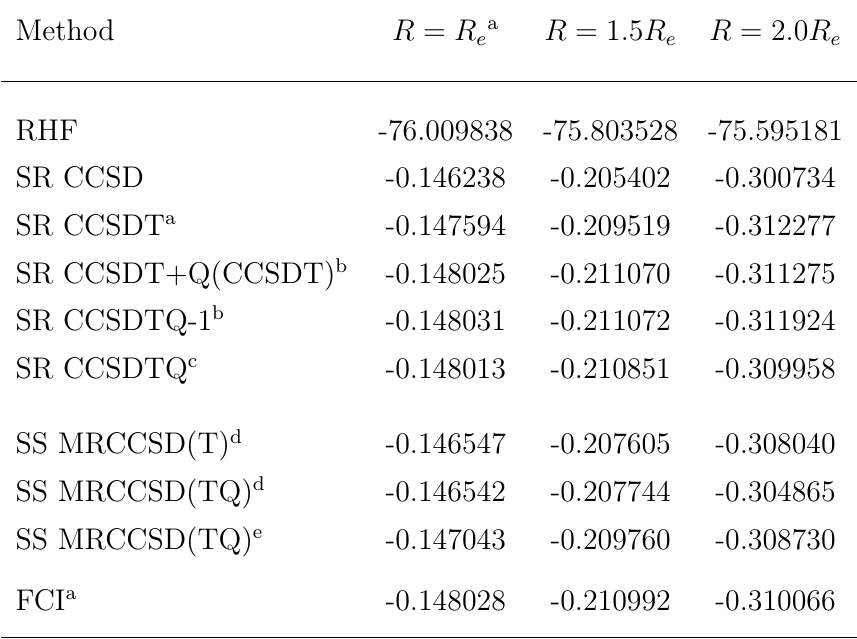
Table 1. A comparison of the SS MRCCSD(T) and SS MRCCSD(TQ) correlation energies (in Hartree) with FCI, SR CCSD, SR CCSDT, SR CCSDT+Q(CCSD), SR CCSDTQ-1, and SR CCS- DTQ results for the H O molecule at the equilibrium ( R = R 2 R = 1 . 5 R and R = 2 R obtained with double zeta (DZ; [4s2p/2s]) basis e e